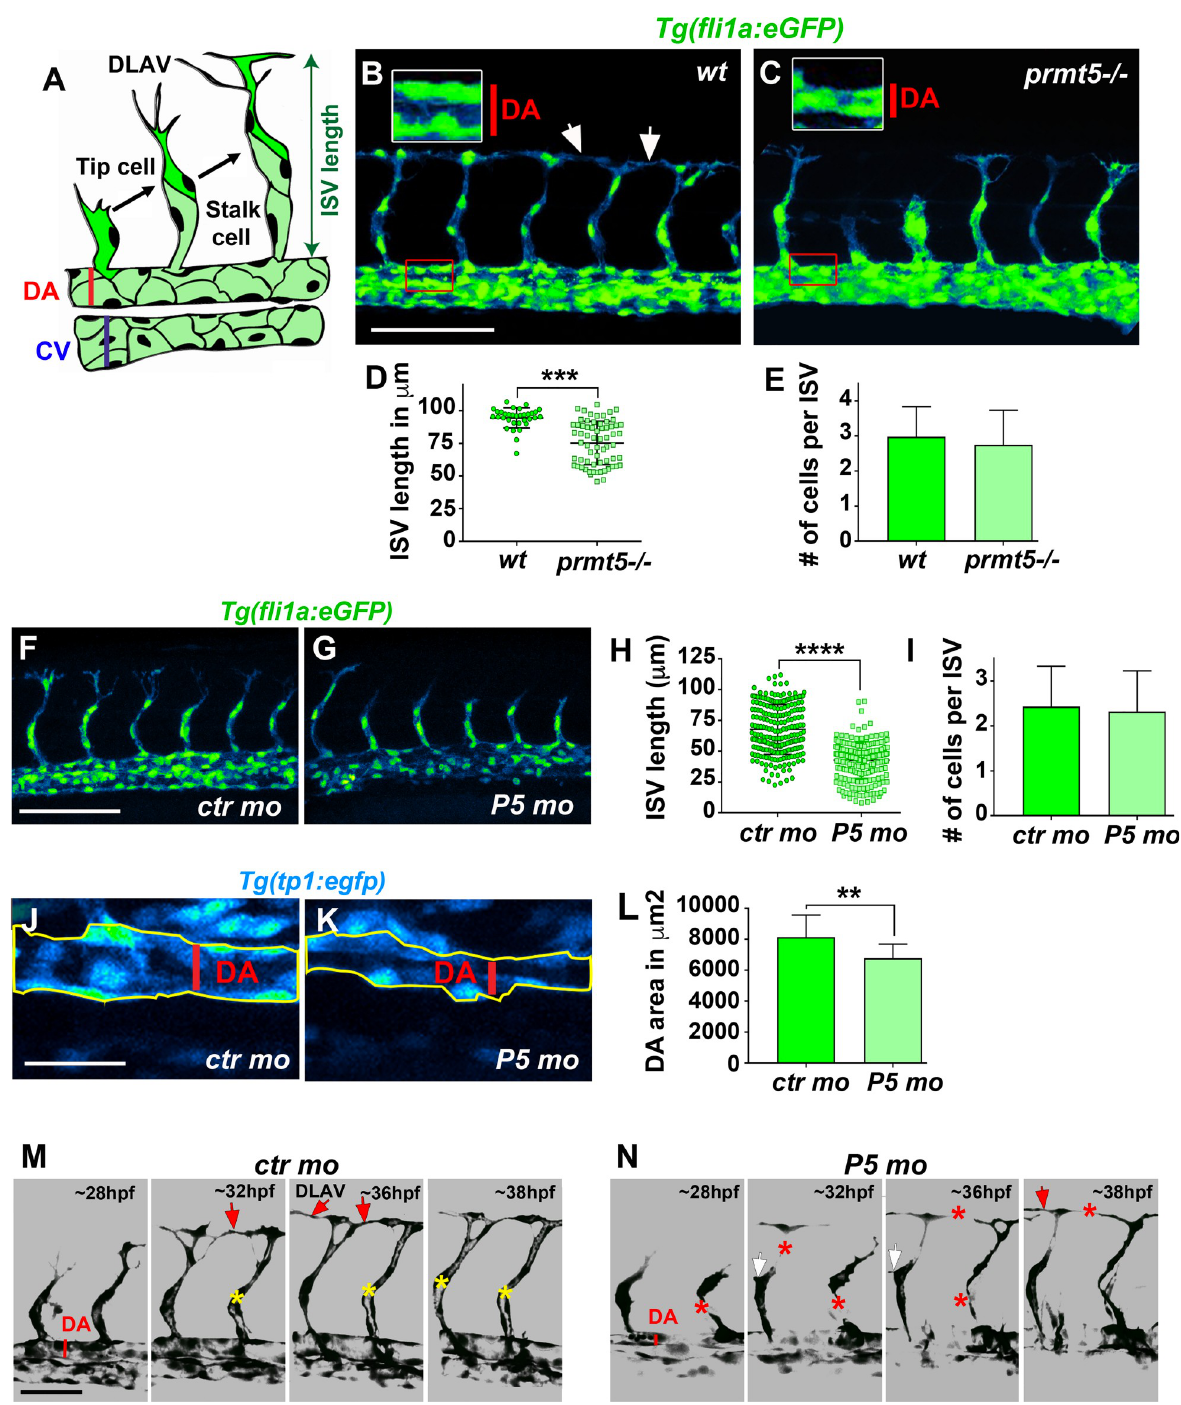
Fig 3. Loss of prmt5 impairs blood vessel formation. (A) Schematic representation of the trunk vasculature with Intersegmental Vessels (ISV) sprouting from the dorsal aorta (DA). The tip cell leads the cell migration and the stalk cell maintains the connection with the DA. CV: cardinal vein. (B, C) Confocal projections of transgenic Tg(fli1a : GFP) y1 wild-type (B) and prmt5 mutant (C) embryos at 28 hpf. Red rectangles delimit where DA close ups were made. White rectangles delimit the higher magnification (x2) of the DA with red lines indicating the dorsal aorta diameters. White arrows indicate the connection point between two ISVs to form the Dorsal Longitudinal Anastomotic Vessel (DLAV). Scale bar 100 μ m. (D, E) Average ISV length in μ m (D) and average number of endothelial cells per intersegmental vessel (E) in control and in prmt5 mutant embryos from 3 independent experiments with at least 3 animals per condition. T-test and Mann Whitney test were performed, respectively. �� P < 0.01,